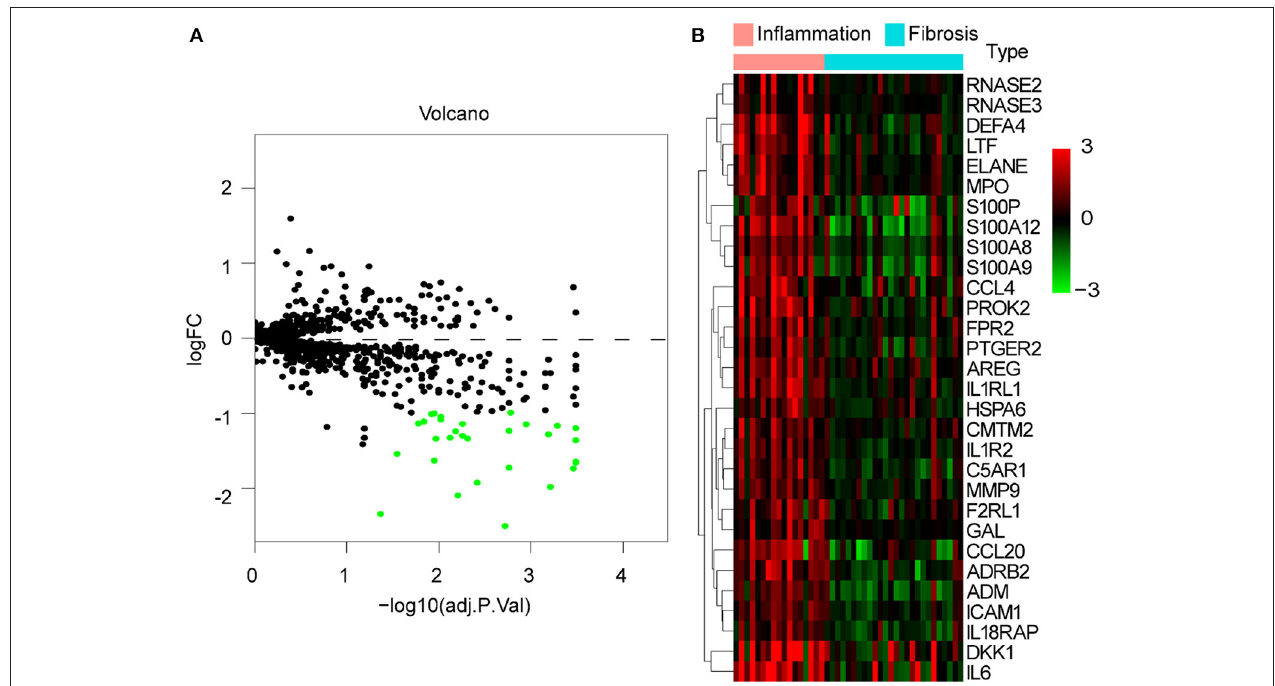
FIGURE 5 | DE-IGs between inflammation and fibrotic livers of BA. (A) The volcano plot of 30 DE-IGs. The red plots represent upregulated genes and the green plots represent downregulated genes. (B) The heatmap reflects the relative expression of DE-IGs in different individuals and the overall difference between the two